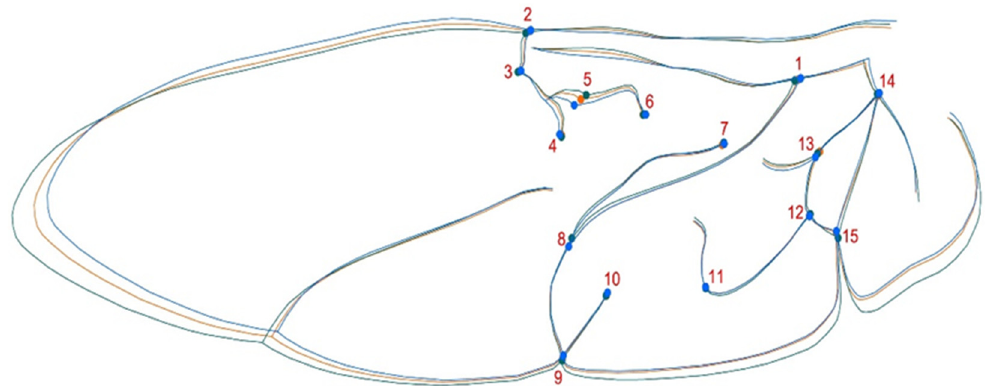
Figure 2. H. axyridis hind wing average shape with landmarks by different forms. Colors represent the three common forms: green, conspicua (co); orange, spectabilis (sp); blue, succinea (su).